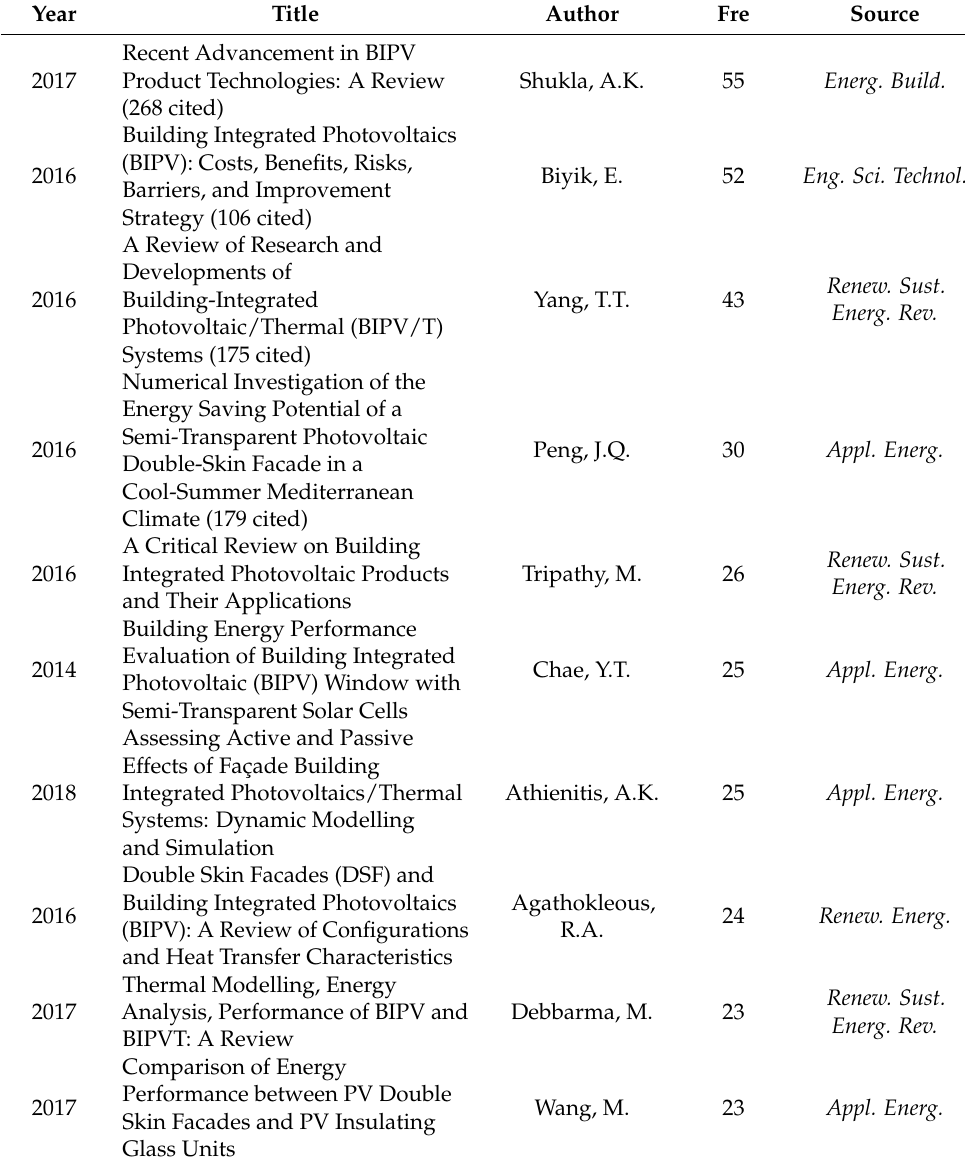
Table 11. The top 10 most co-citations and co-occurrences of